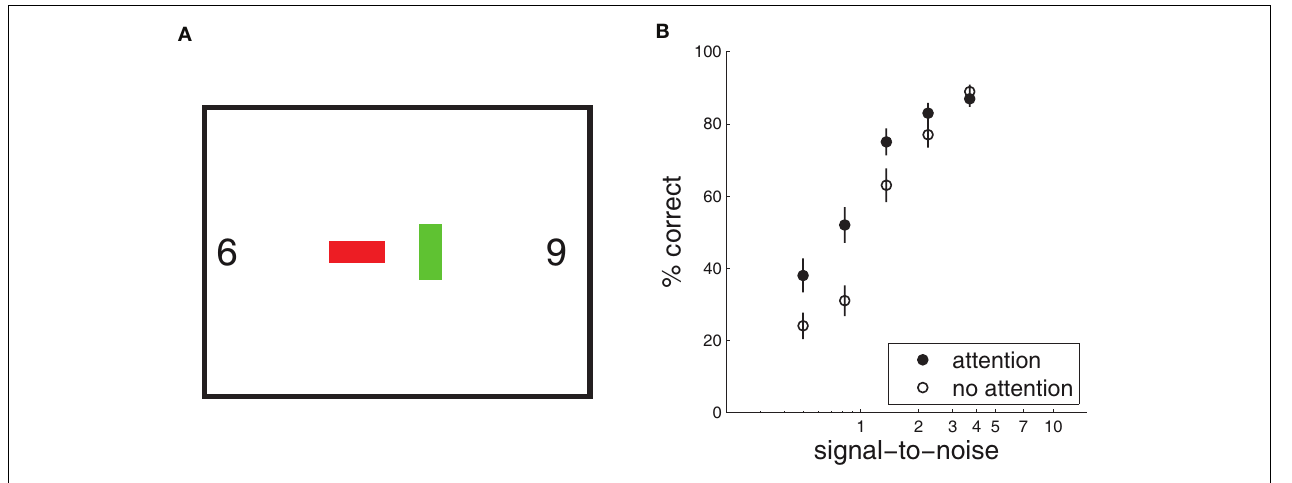
was sometimes distracted by a task involving the peripheral digits. (B) Model performance with and without attention. More binding errors are made when attention is